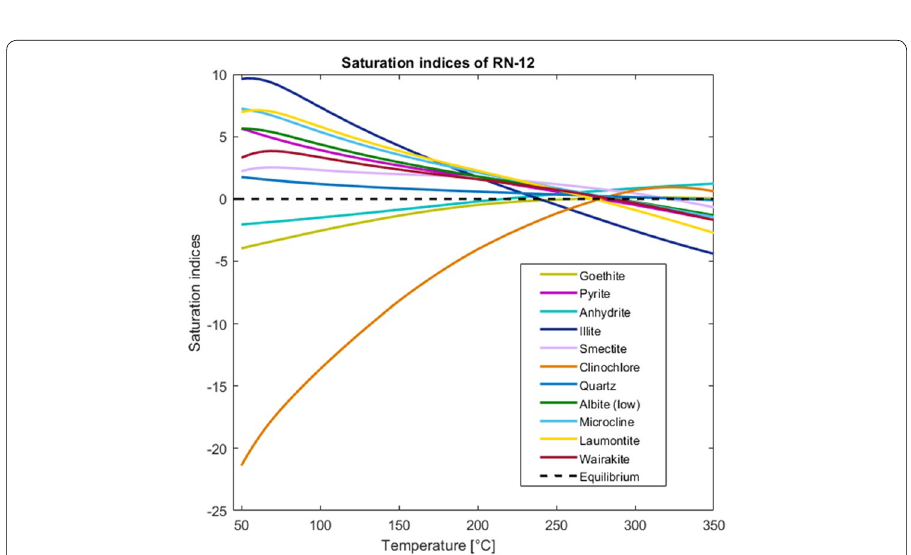
Fig. 9 Initial saturation indices of the basalt-specific mineral set of RN-12 with a temperature range of up to 350 °C prior to the sensitivity analyses. Saturation curves approaching the critical point of water have to be used with